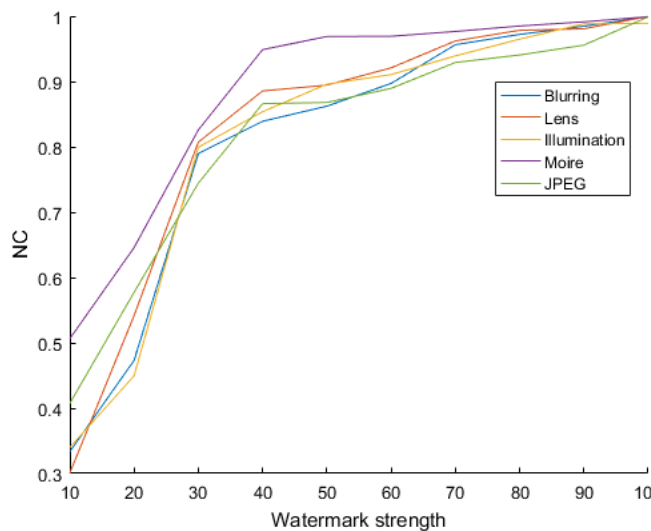
Figure 7. NC of the five attacks with different watermark